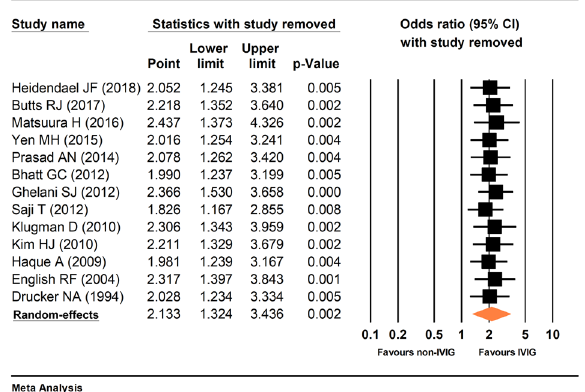
Figure 3. Sensitivity analysis. Forest plot showed each pooled result, having excluded a study, compared to the pooled result including all studies.